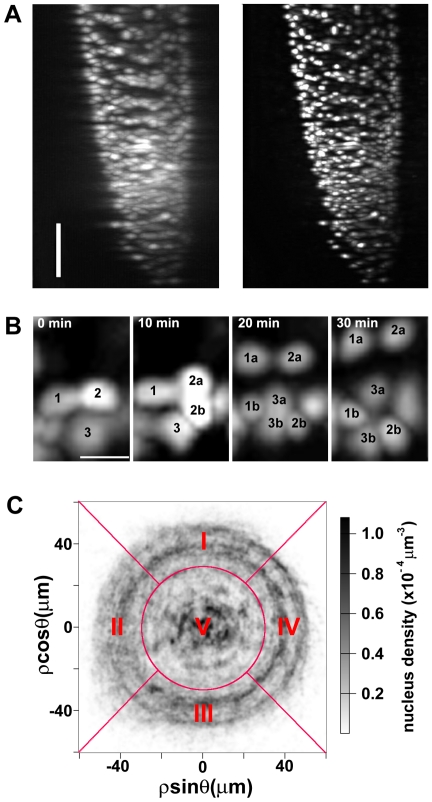
Deconvolution and segmentation.(A) Arabidopsis root expressing 35S::H2B::YFP. Maximum intensity projections before (left panel) and after (right panel) deconvolution; the horizontal axis corresponds to the objective axial dimension; bar, 50 µm. (B) Cell divisions from same root in (A), time-lapse. Three cells divide giving rise to daughters labeled with “a” and “b”; bar, 5 µm. (C) Density plot of segmented nuclei. Projection along the longitudinal axis of all the nuclei recognized by the segmentation, accumulated in a 29 hour period. Five regions used in Table S1: I, towards objective; II, away from laser source; III, away from objective; IV towards laser source; V center of the root (ρ<30 µm).